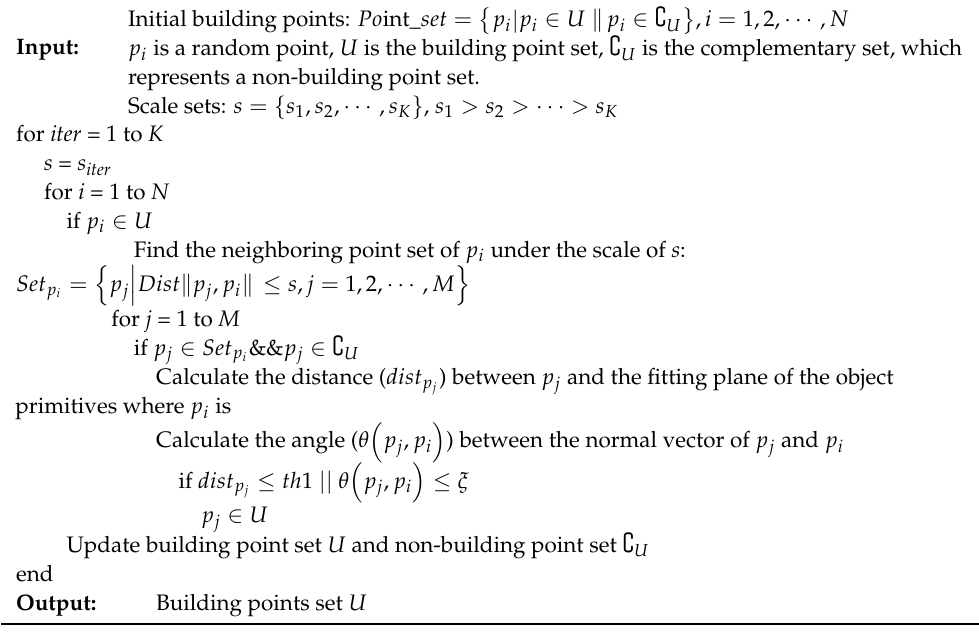
Algorithm 1. Building points optimization based on multi-scale progressive growing.